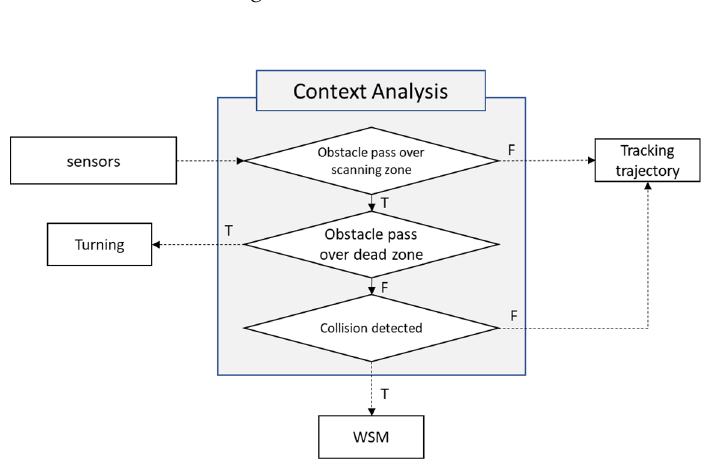
Figure 10. Illustrating dead zone and scanning zone of the robot.